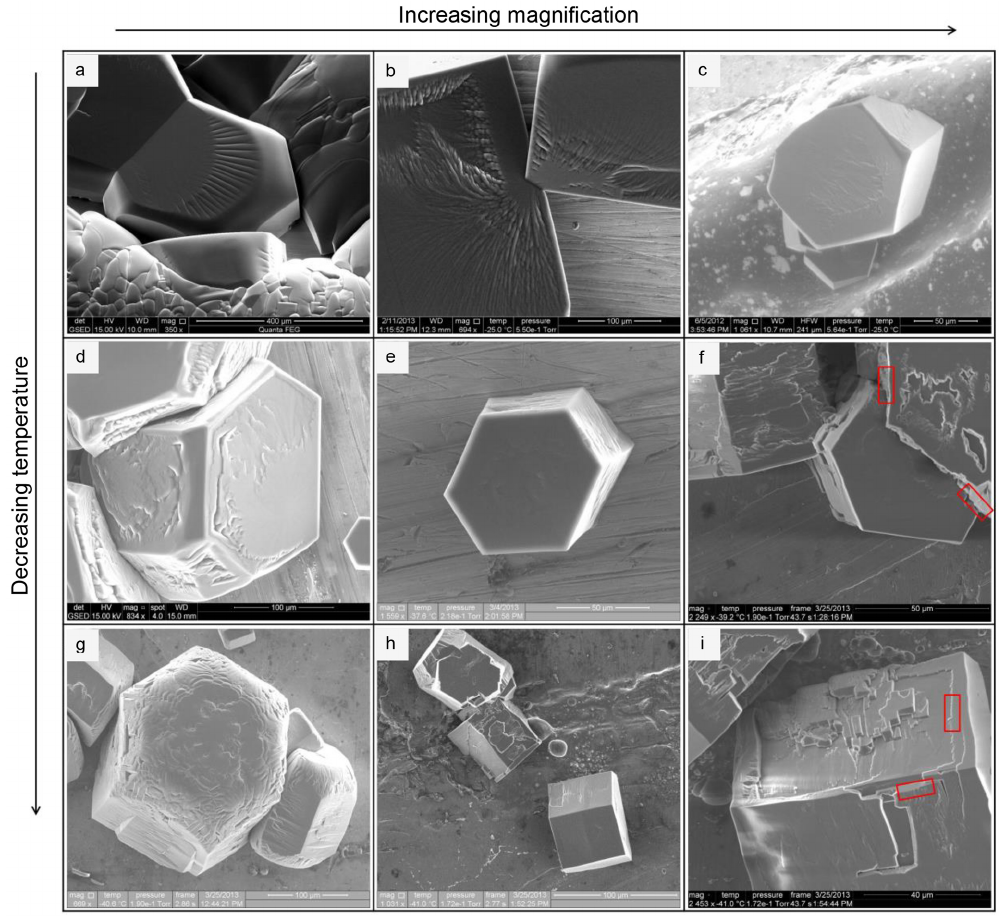
Figure 1. Image panels at a variety of magnification, temperatures, and pressures, all showing various examples of mesoscopic surface topography. Red rectangles in panels (f) and (i) show sites used for calculating roughness measure <r> . Data detail available in